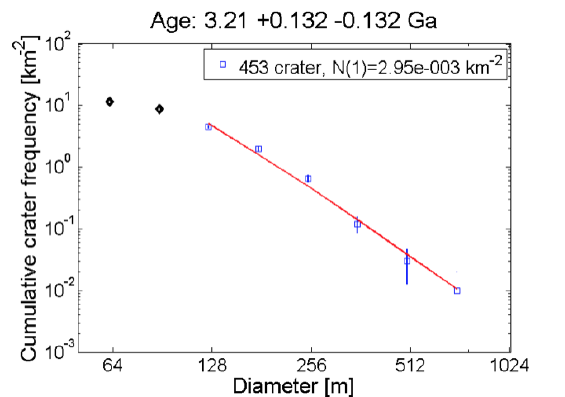
Figure 2. AMA obtained based of the craters in the reference region in the diameter range 128–1000m.